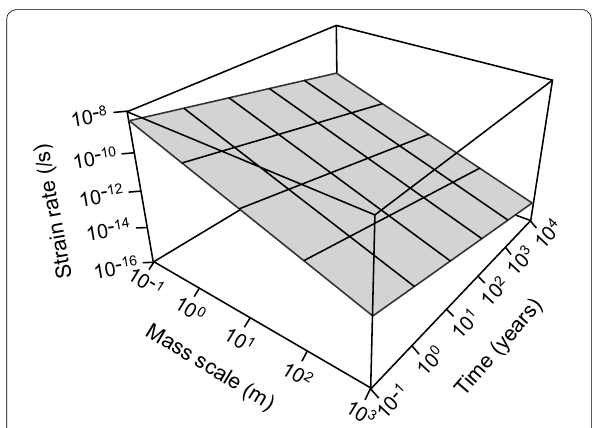
Fig. 14 Evolution of the strain rate controlled by water diffusion for different rock masses and time